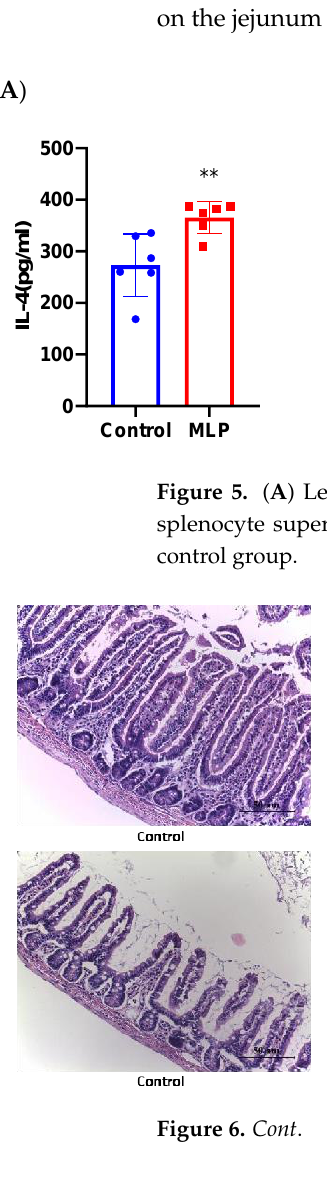
Figure 6. Histological sections (HE) of intestine (( A ): jejunum; ( B ): ileum; ( C ): colon) tissues from the MLP high-dose group and MLP low-dose group. 4. Discussion As an important source of protein supplement, Moringa oleifera leaves have been in- troducedor importedto many countries that did not previously grow and eat Moringa oleif- era leaves because of their extremely high protein content and nutrients [6]. Almost all edible plants have been reported to cause allergies [50]. As a food rich in plant protein, MLP may contain allergen protein. In general, many allergens in plants are mainly com- posed of proteins with low molecular weight and disulfide bonds. According to these properties, we determined the molecular weight, three-dimensional structure, and com- position of the extracted MLP.SDS-PAGE gel electrophoresis is mainly used to determine the molecular weight of allergens [51]. However, the relative mobility of some proteins in the SDS system does not show a linear relationship with their molecular weights, so SDS- PAGE shows errors in determining molecular protein weights. To more accurately deter- mine the molecular weight of MLP, we also used the MALDI-TOF-MS method to accu- rately determine the molecular weight of protein subunits from Moringa oleifera leaves, as shown in Figure 2. To better understand the properties of MLP used in this study, the protein structure and amino acid composition were identified by infrared spectroscopy and amino acid analysis. The structural information of these proteins ’ molecular weight can also help to further the functional identification of leaf proteins. This result will pro- vide some basic information for a better understanding of the potential allergens of MLP. Although there have been clinical literature reports of allergic reactions to Moringa oleifera seeds, there is no report of allergic reactions to Moringa oleifera leavesnor